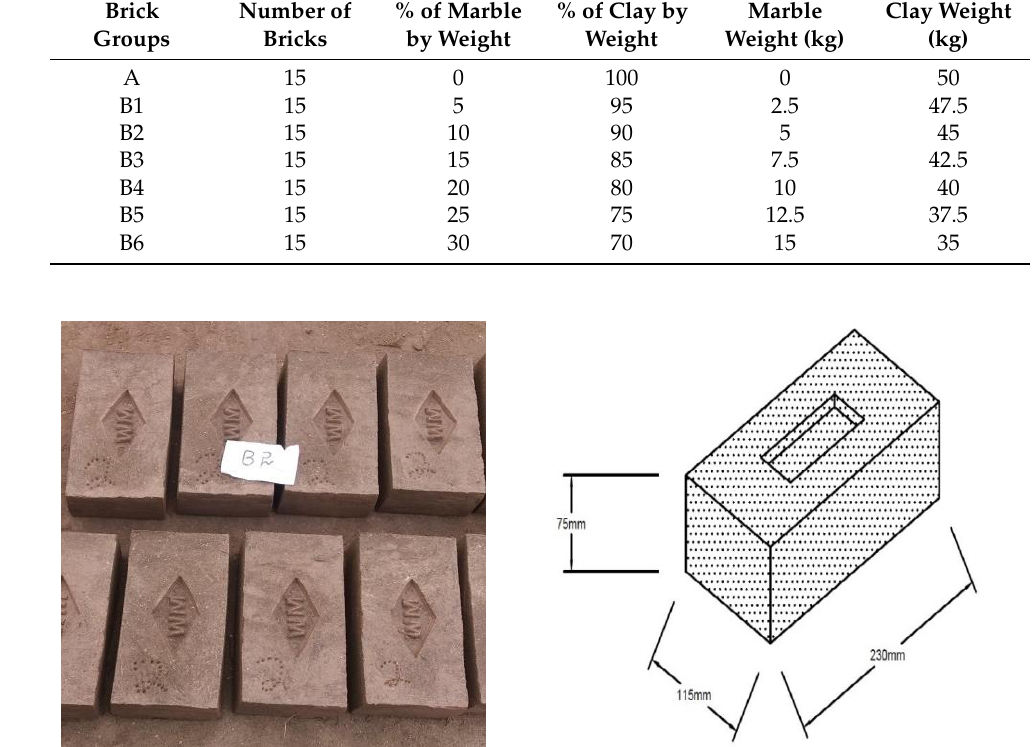
Table 1. Proportions of marble powder in the clay bricks.